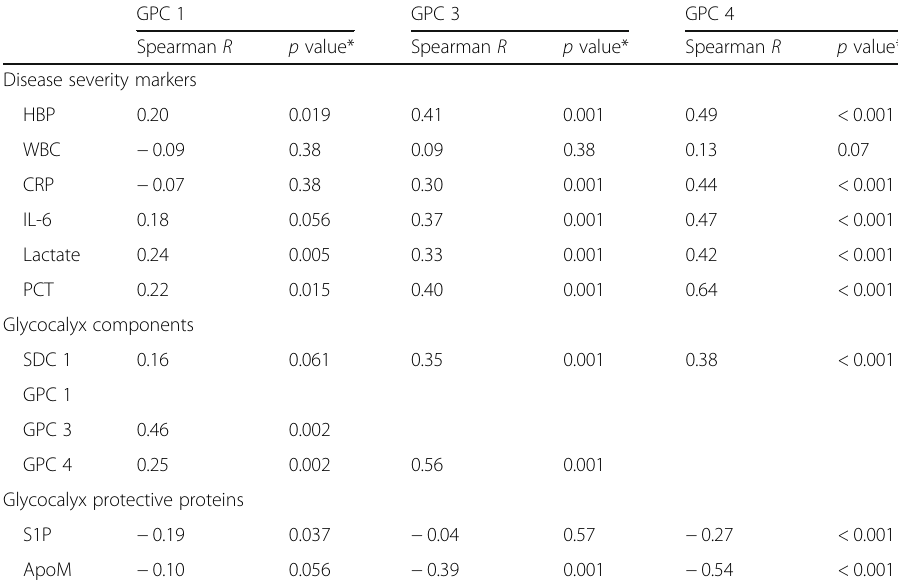
Table 3 Correlation of plasma GPC 1, 3 and 4 with plasma levels of markers of inflammation and disease severity, and with proteins associated with the